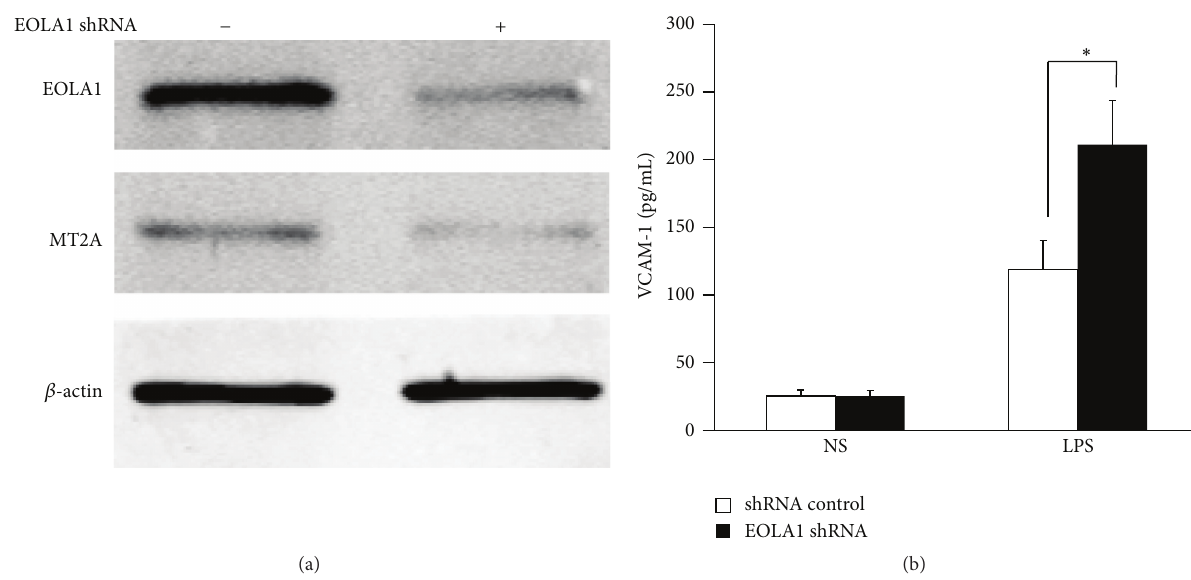
Figure 4: Knockdown of EOLA1 with shRNA inhibits the expression of MT2A and increases the LPS-induced VCAM-1 production in ECV304 cells. (a) ECV304 cells were transfected with control or EOLA1 shRNA for 48 h. The cells were lysed and analyzed by Western blotting with anti-EOLA1 or anti-MT2A antibodies, 𝛽 -actin as a loading control. (b) ECV304 cells were transfected with control or EOLA1 shRNA for 24 h and then cultured with or without LPS (100ng/mL) and the concentration of VCAM-1 in the culture supernatants was determined 6 h after stimulation. Data represent the mean ± SD of three independent experiments ( ∗ 𝑝 < 0.05 ).